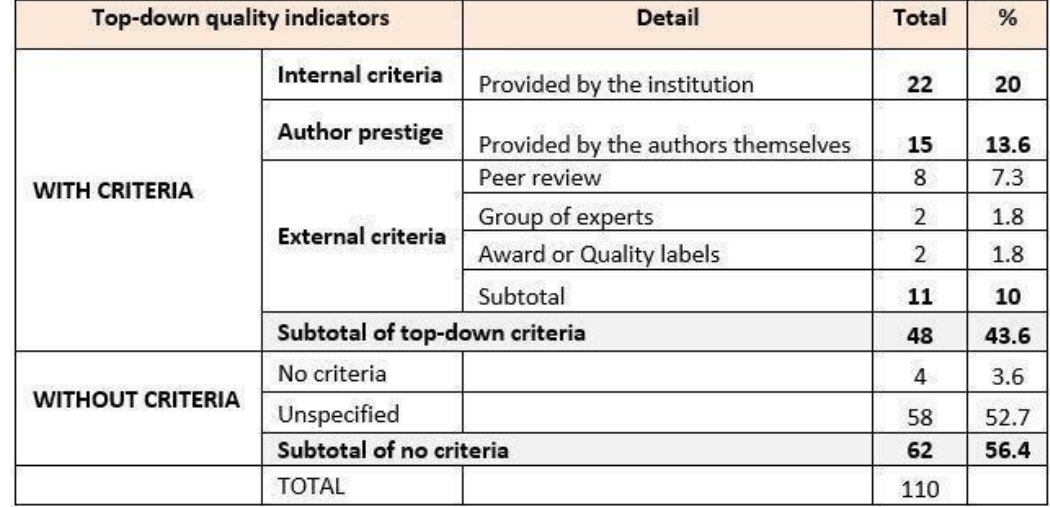
Top-Down Quality